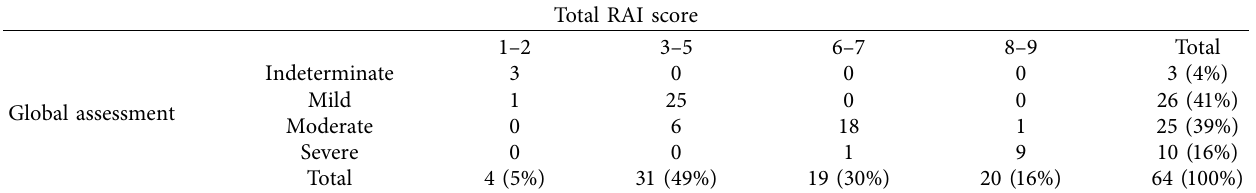
Table 4: Te biopsies with T cell-mediated rejection (TCMR) according to the Banf working group’s consensus for global assessment categories and the rejection activity index (RAI).